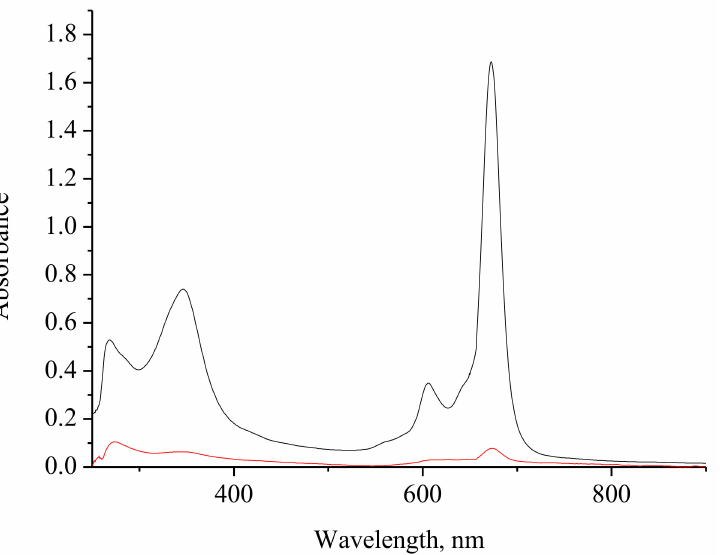
Figure 5. UV-Vis spectra of CuPc in DMF obtained by extraction from the initial CS-CuPc (red line) and heated to 225 ◦ C CS-CuPc (black line) with